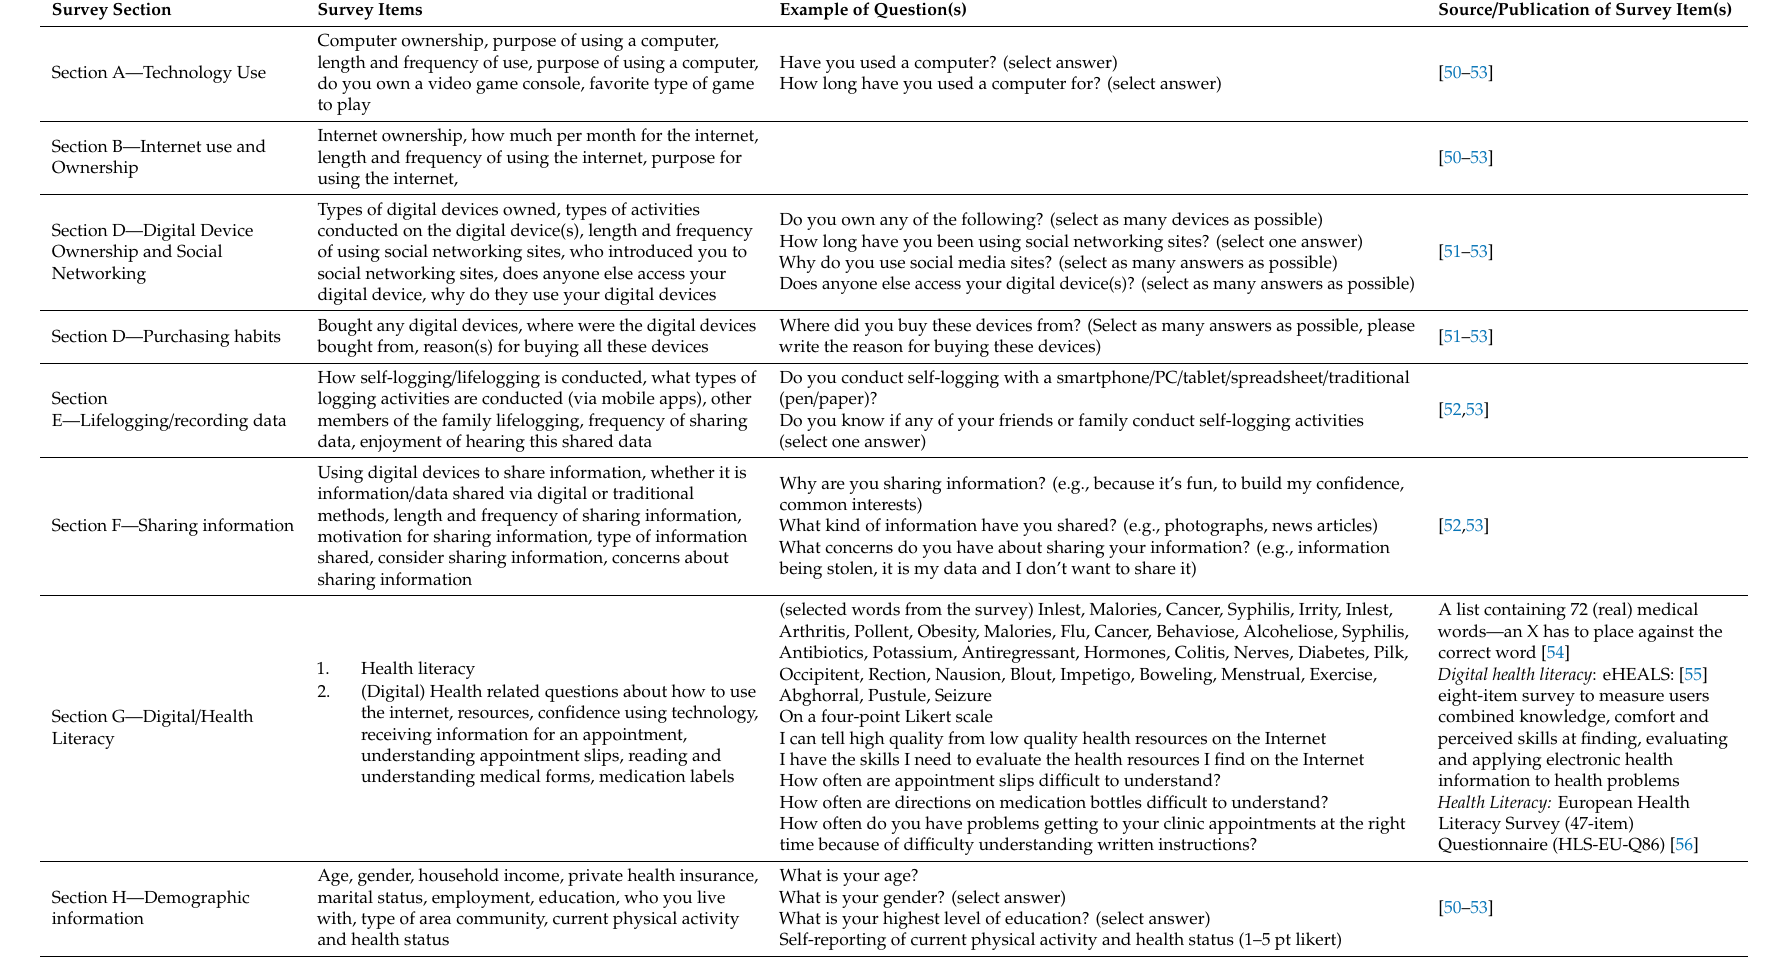
Table 2. The di ff erent survey sections, items, and example